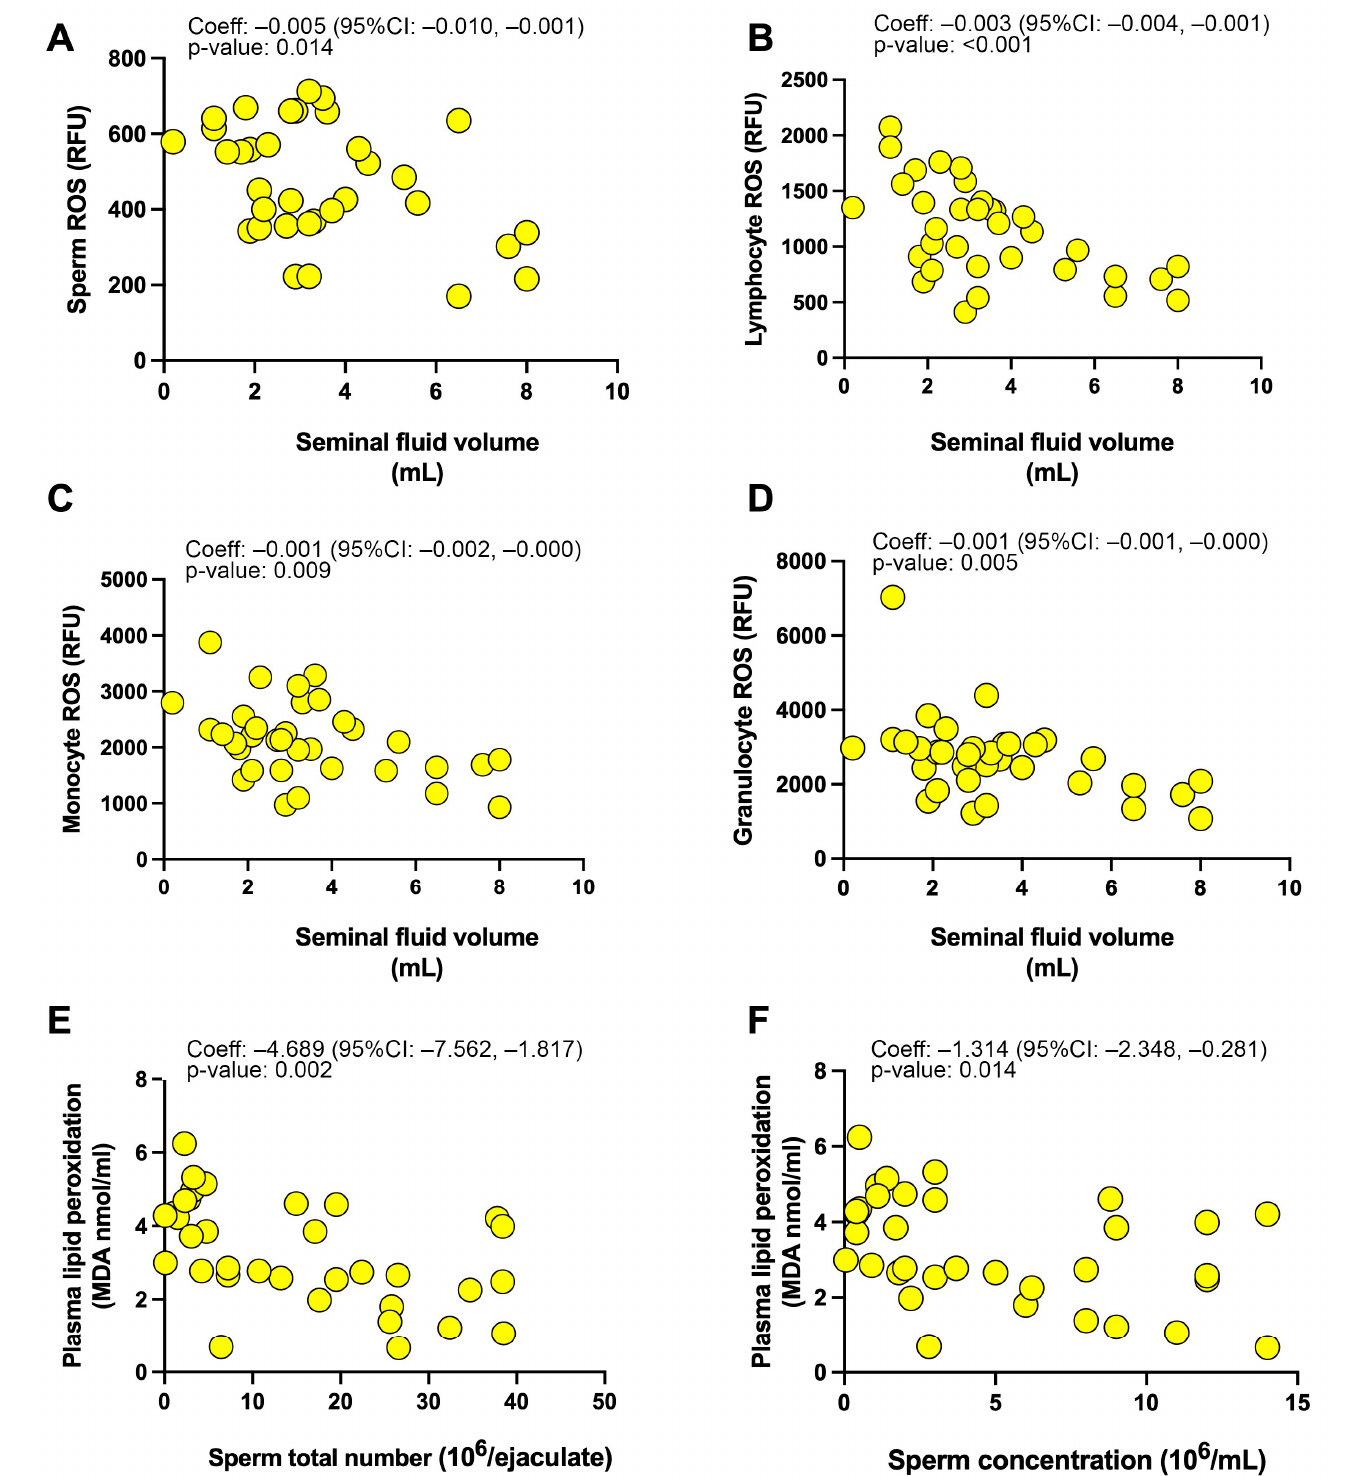
Figure 2. Linear regression coefficient and graphical plots of ( A ) sperm ROS production and seminal fluid volume, ( B – D ) leukocyte ROS production and seminal fluid volume, ( E , F ), plasma lipid peroxidation and sperm total count ( E ) and sperm concentration ( F ). Conversely, when only control subjects were considered (Supplementary Table S1), no significant correlation emerged between sperm or systemic plasma redox parameters and sperm quality features.